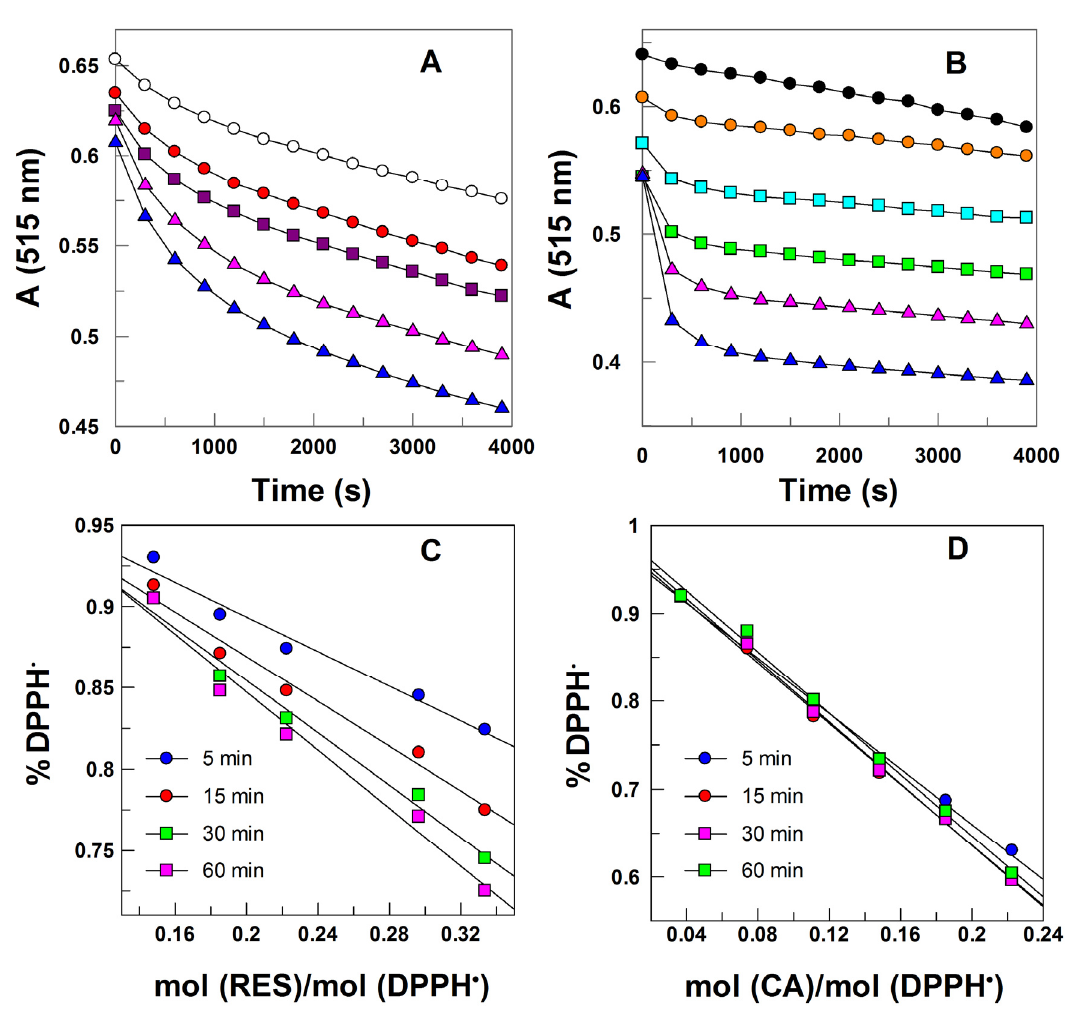
Figure 7. ( A ) Variation of the absorbance of 2,2-diphenyl-1-picrylhydrazyl (DPPH) in the presence of different concentrations of RES at T = 25 °C (-  - 0.1483 mol RES/mol DPPH, -  - 0.1854 mol RES/mol DPPH -  - 0.2223 mol RES/mol DPPH, -  - 0.2966 mol RES/mol DPPH, -  - 0.3337 mol RES/mol DPPH); ( B ) variation of the absorbance of DPPH in the presence of different concentrations of CA at T = 25 °C (-  - 0.0371